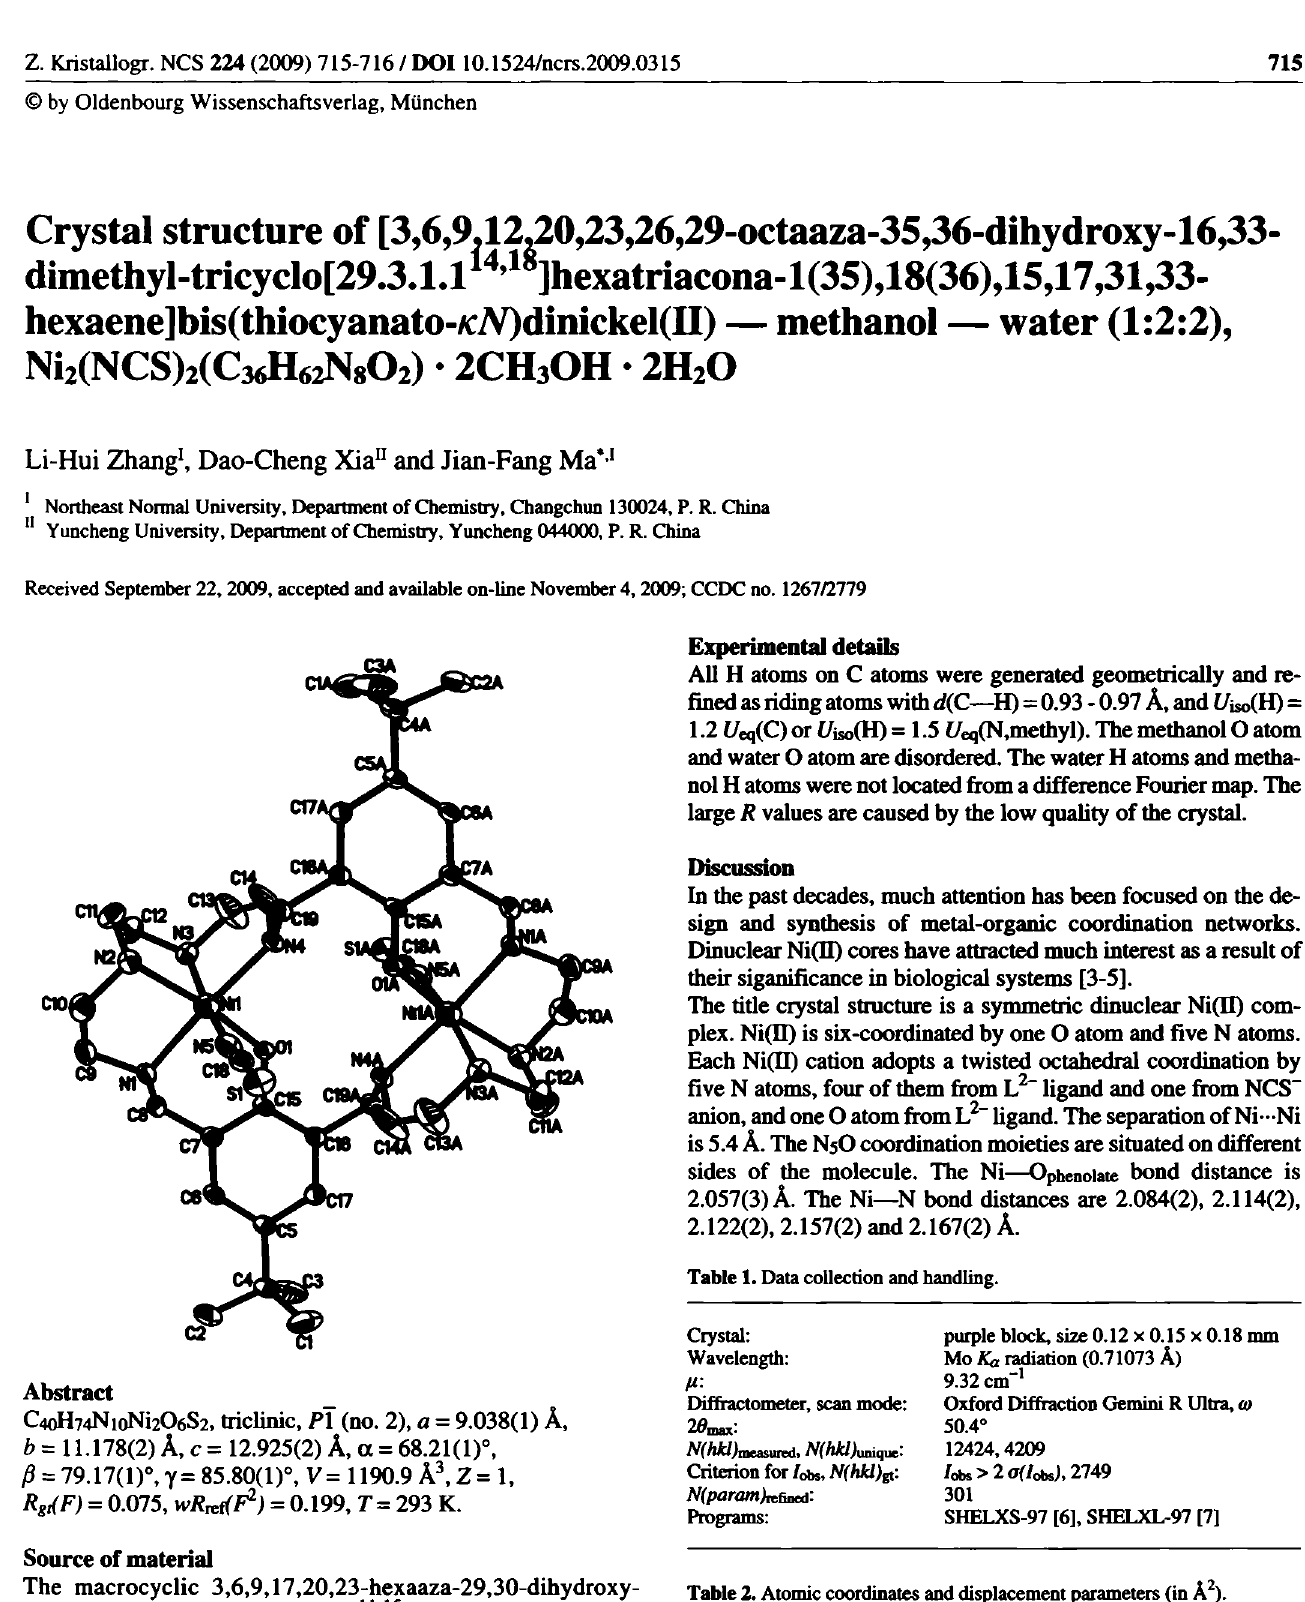
Table 2. Atomic coordinates and displacement parameters (in Â 2